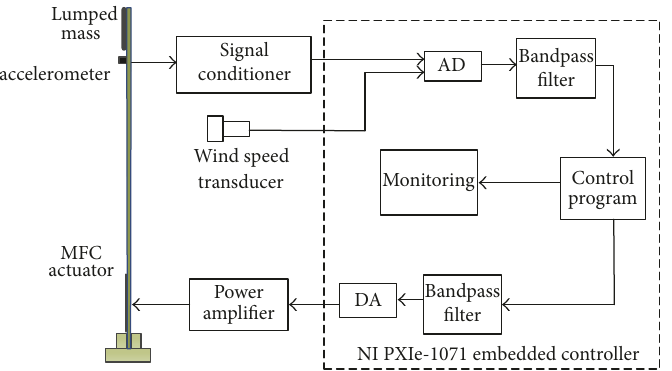
Figure 6: Block diagram of flutter control system of wing model for wind tunnel